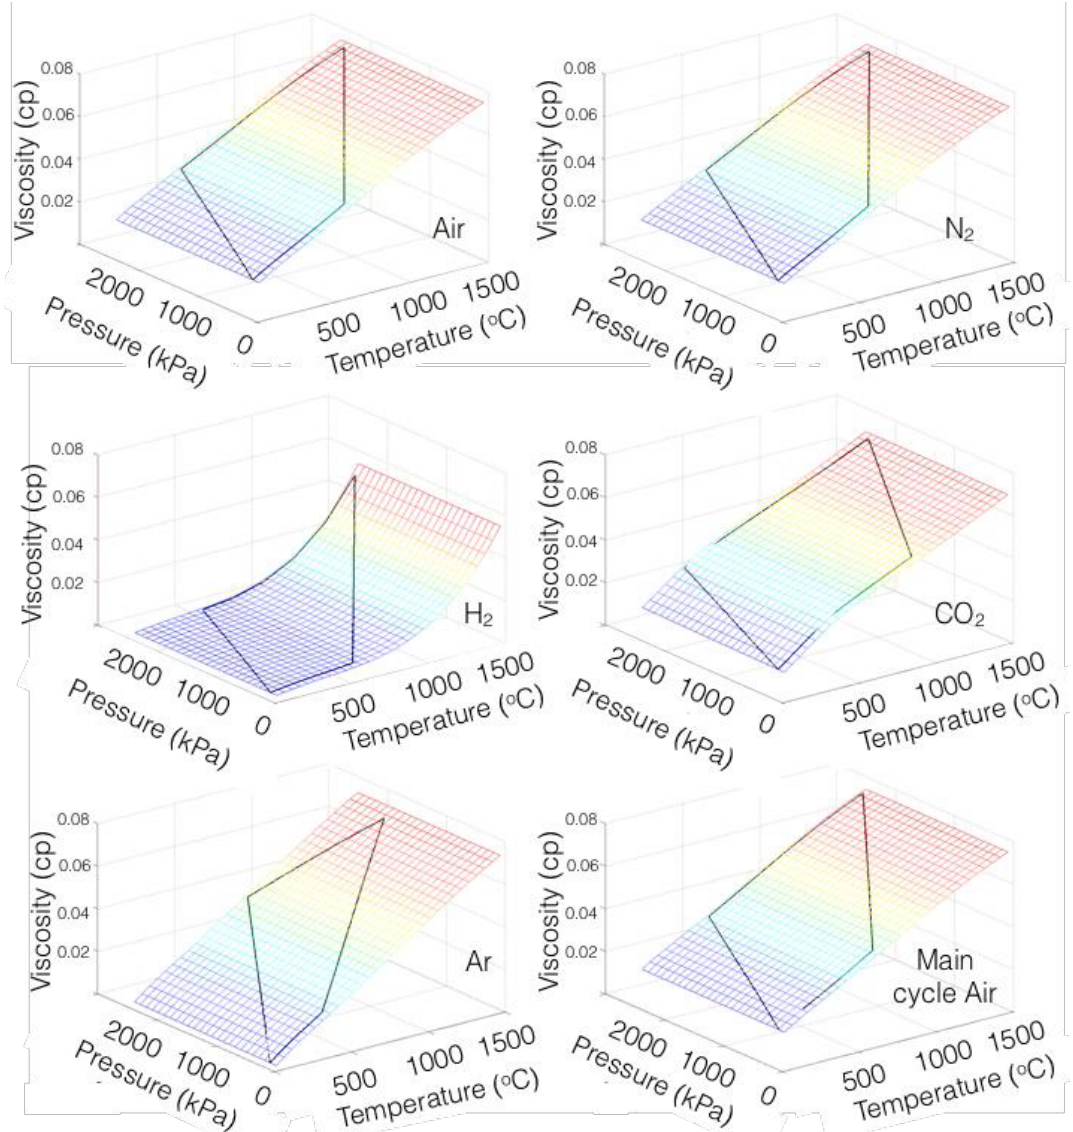
Figure 7. Viscosity change for different fluids shown as 3D surface plots. Black lines represent the viscosity profiles of the partitioned Brayton cycle at 92.7% adiabatic efficiency.